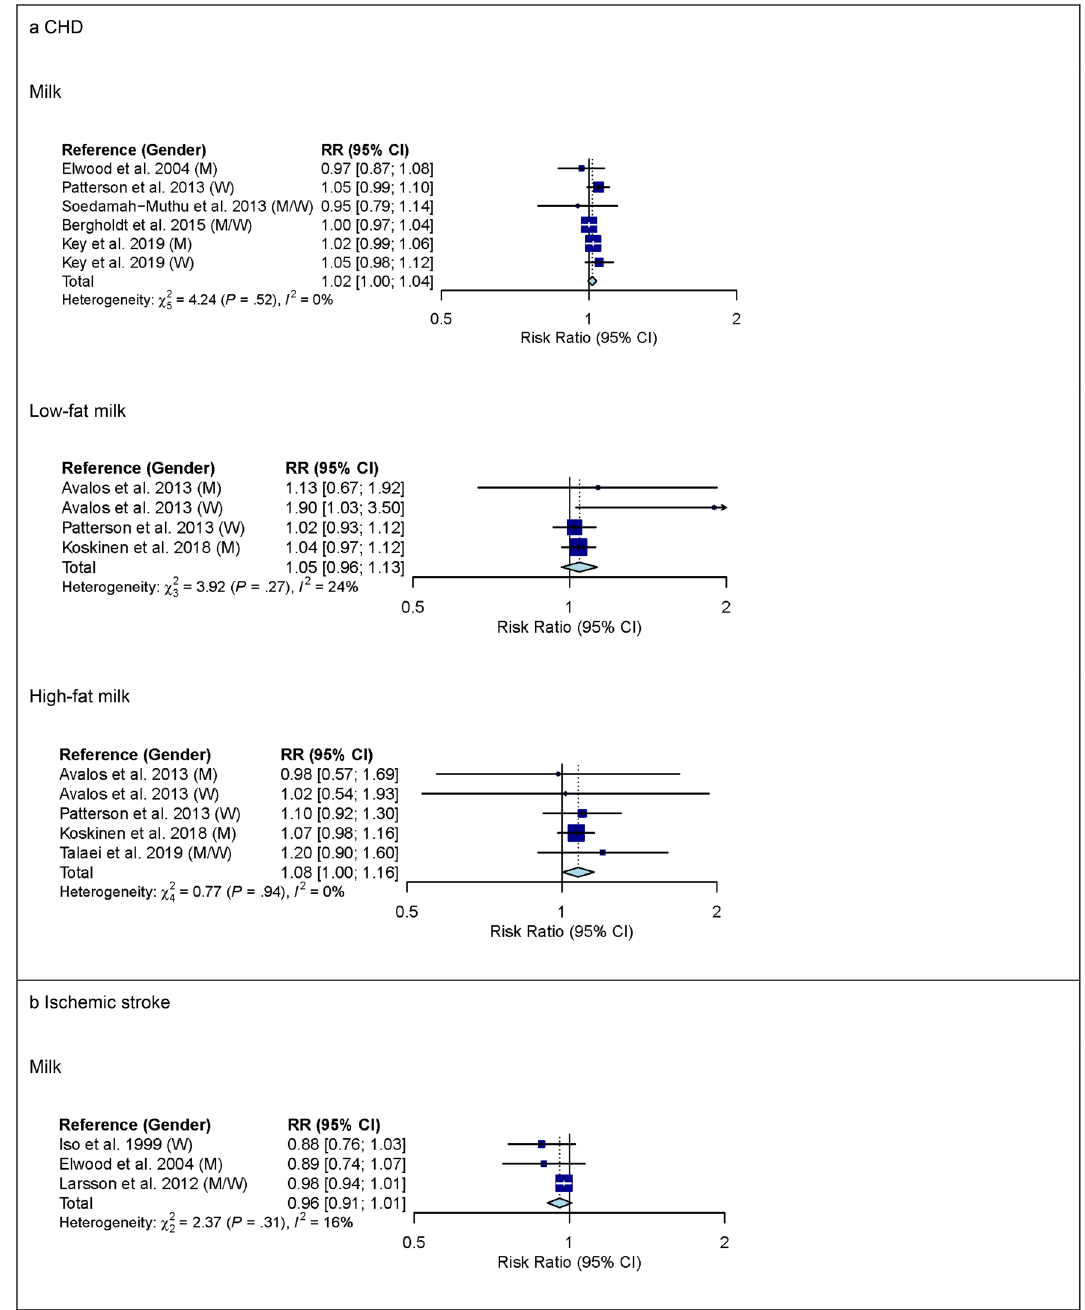
Figure 1. Linear dose–response meta-analysis. Summary RR of CHD (panel a ) and ischemic stroke (panel b ) per 200 g higher intake of milk/day. P = 0.12 for the association between milk and CHD. P = 0.04 for the association between high-fat milk and CHD. CHD coronary heart disease; CI confidence interval; M males; RR risk ratio; W